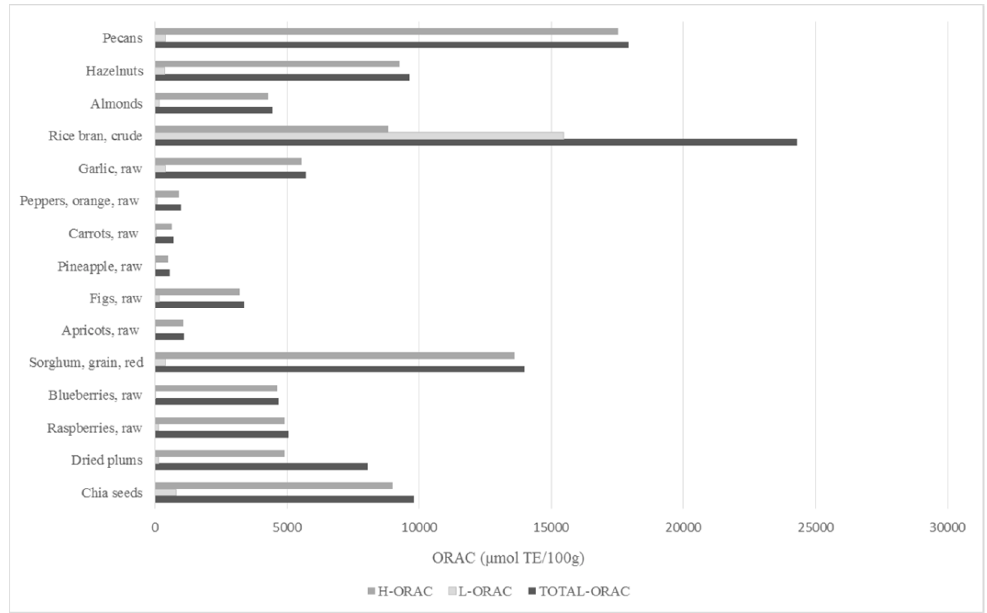
Figure 3. ORAC values for antioxidant activity of selected foods [60,61]. ORAC, Oxygen Radical Absorbance Capacity; H-ORAC, hydrophilic ORAC value for water soluble antioxidants; L-ORAC, lipophilic ORAC value for lipid soluble antioxidants; TE, Trolox equivalents; compilation of results.